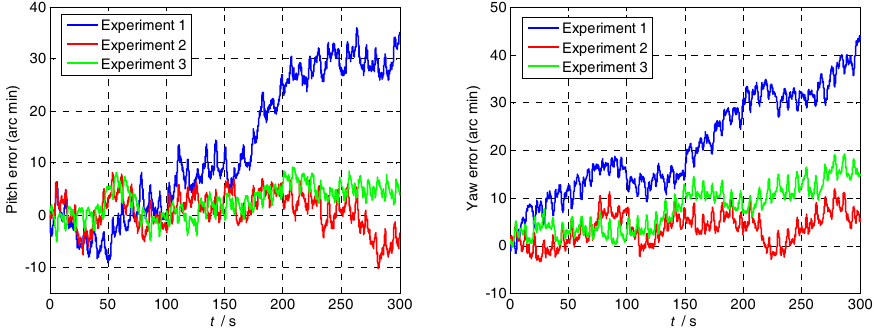
Figure 13. Pitch and yaw error curves of the three experiments.